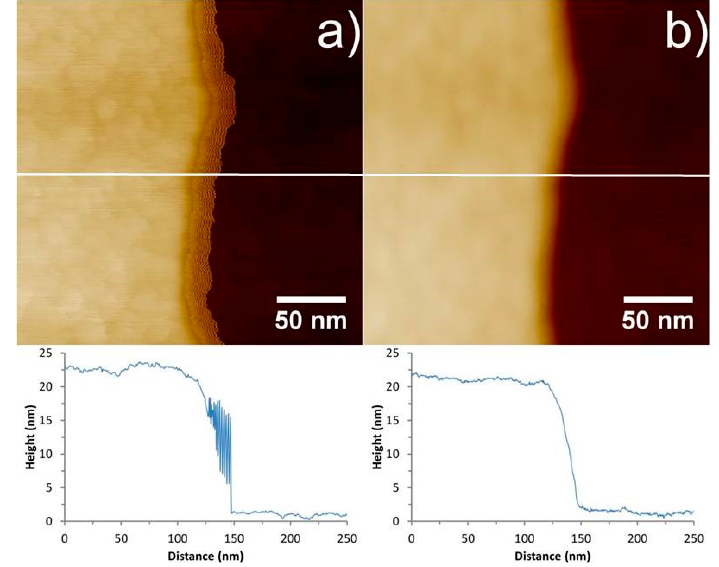
Figure 4. AFM images and corresponding cross sections of a Mikromasch TGZ01 calibration grid with 20 nm deep parallel trenches using the CNT2 probe. Image ( a ) was acquired in tapping mode, while image ( b ) was acquired using PFT. The white lines represent the positions of the cross sections underneath each image. From the images and cross sections it is obvious that the “ringing” artefact is eliminated when using CNT-AFM tips in PFT mode. The height or color scale for both images is 50